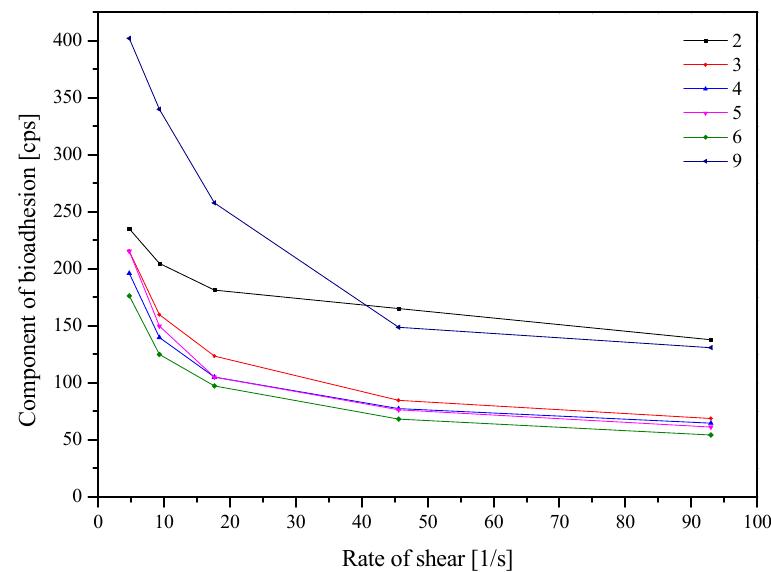
Figure 8. Component of bioadhesion of the nanofibers.